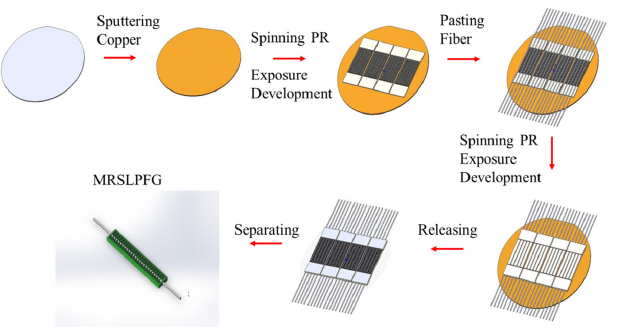
Figure 1. Flowchart of micro rectangular ‐ shaped long ‐ period fiber grating (MRSLPFG) fabrication process.